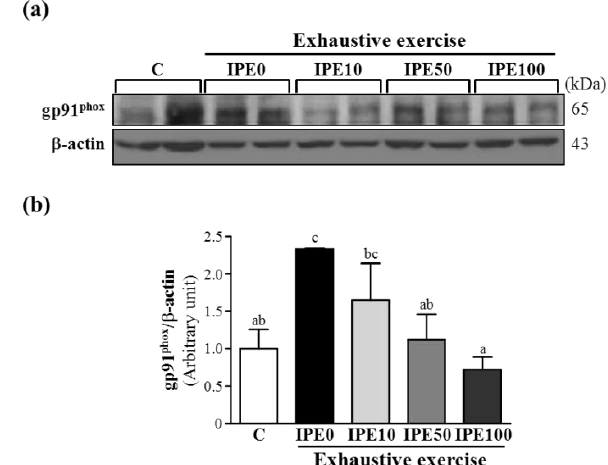
Figure 3. Effect of I. parviflora extract (IPE) supplementation on levels of the gp91 phox subunit of NADPH oxidase in liver tissues after an exhaustive swimming exercise challenge. ( a ) Western blot of gp91 phox and  -actin expression levels in the liver; ( b ) gp91 phox protein expression was normalized to that of  -actin (internal control) by